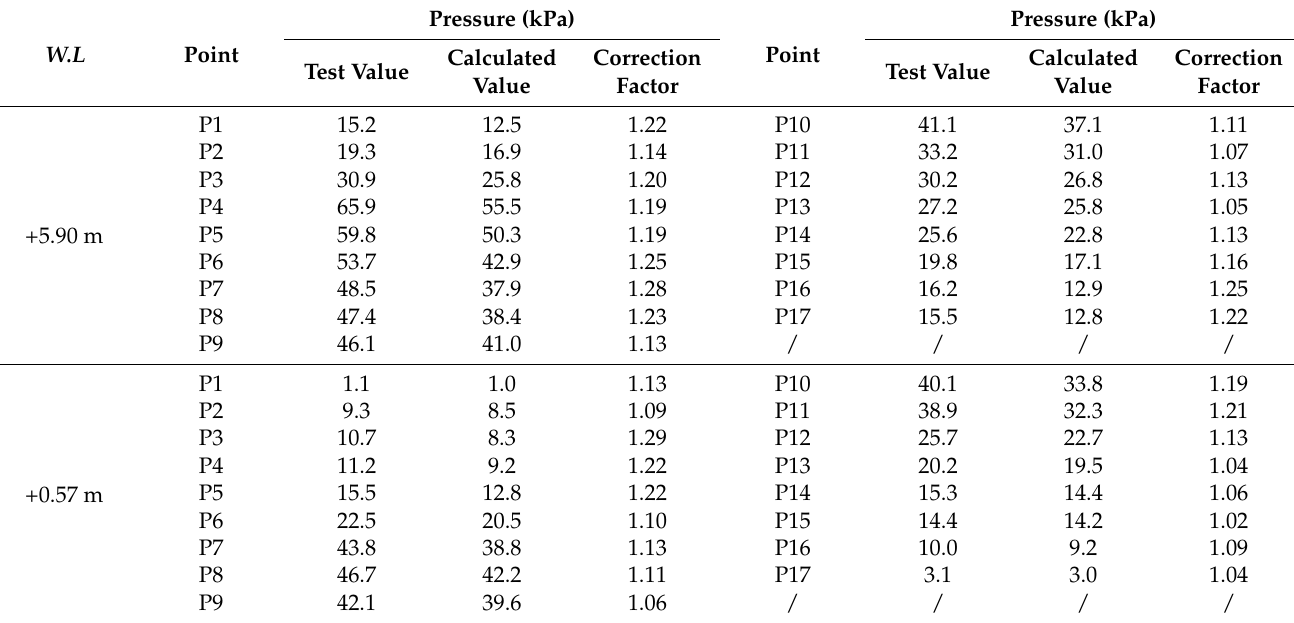
Table 6. Comparison of the test and calculated maximum pressure